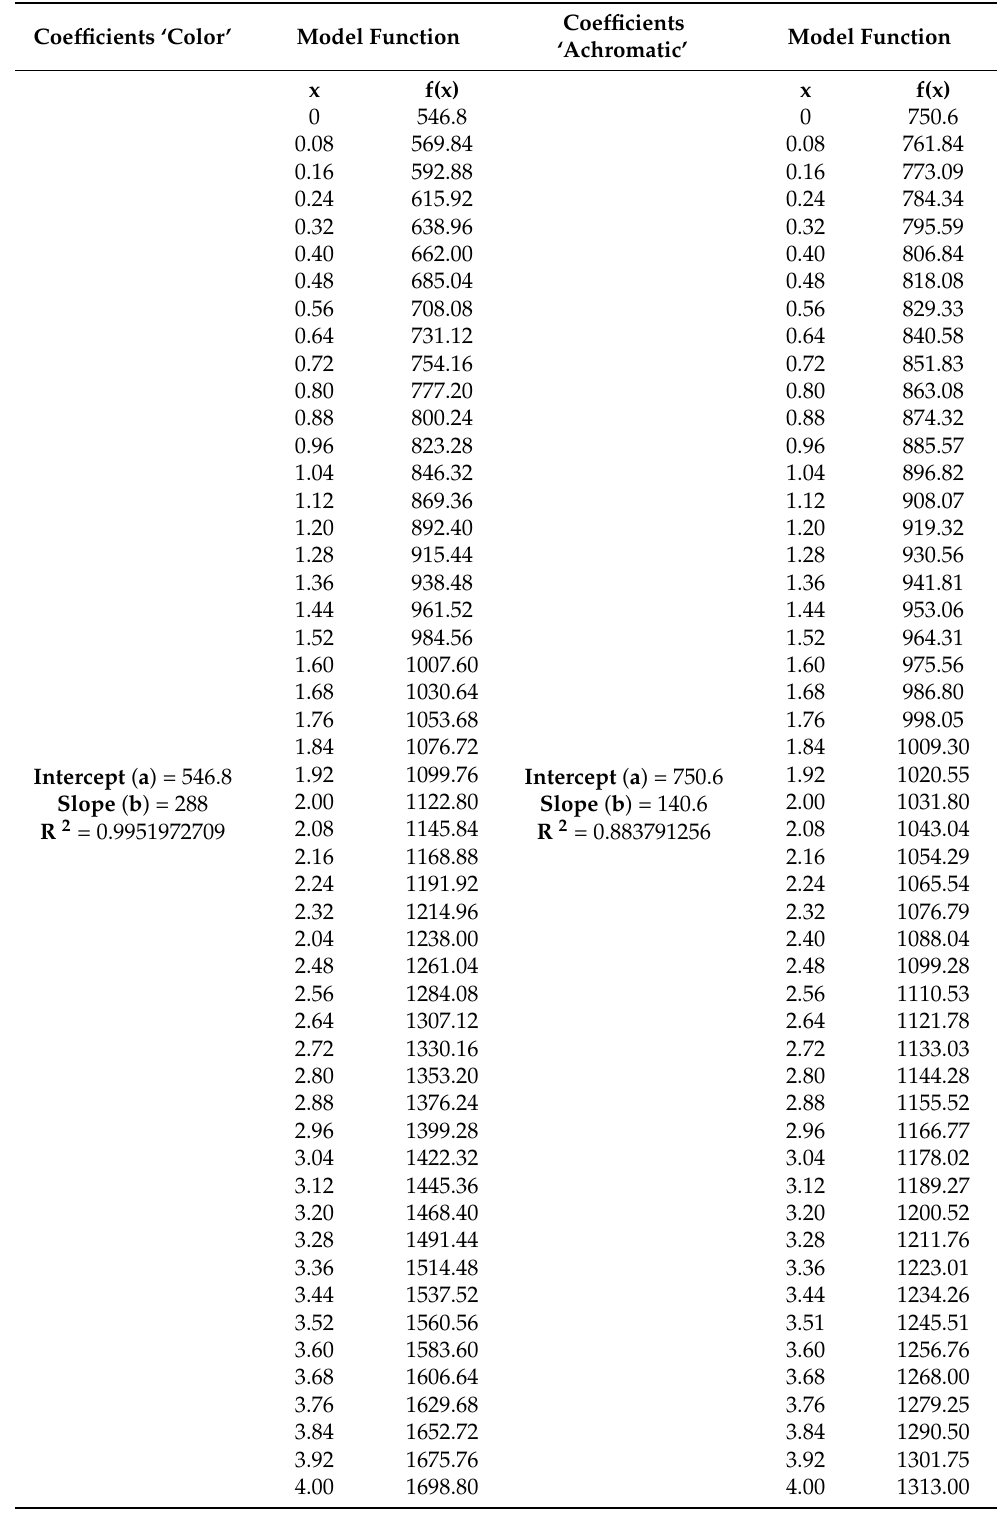
Table 5. Results of the linear regression analysis on average RT for the two levels of the hue factor as a function of the five levels of the variability